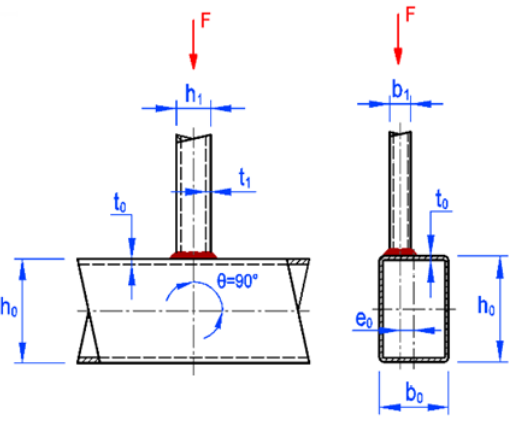
Figure 1. Welded o ff set T-joint